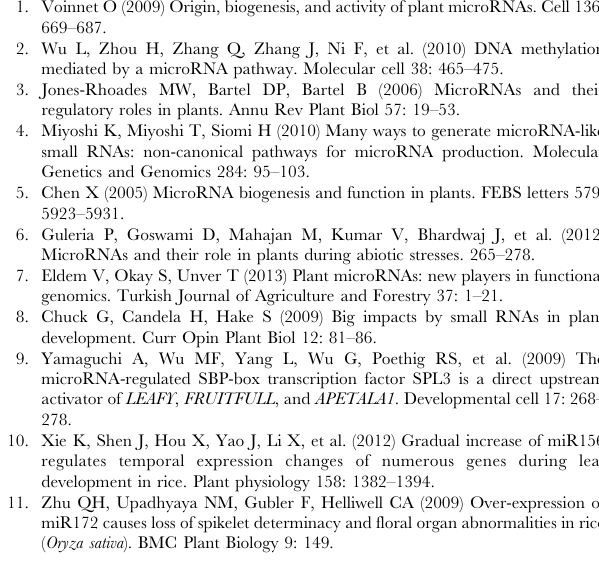
Figure 7. Quantitative real-time RT-PCR analysis of the relative expression of flowering miRNAs in the three sRNA libraries. The data represent the mean values 6 SD of three